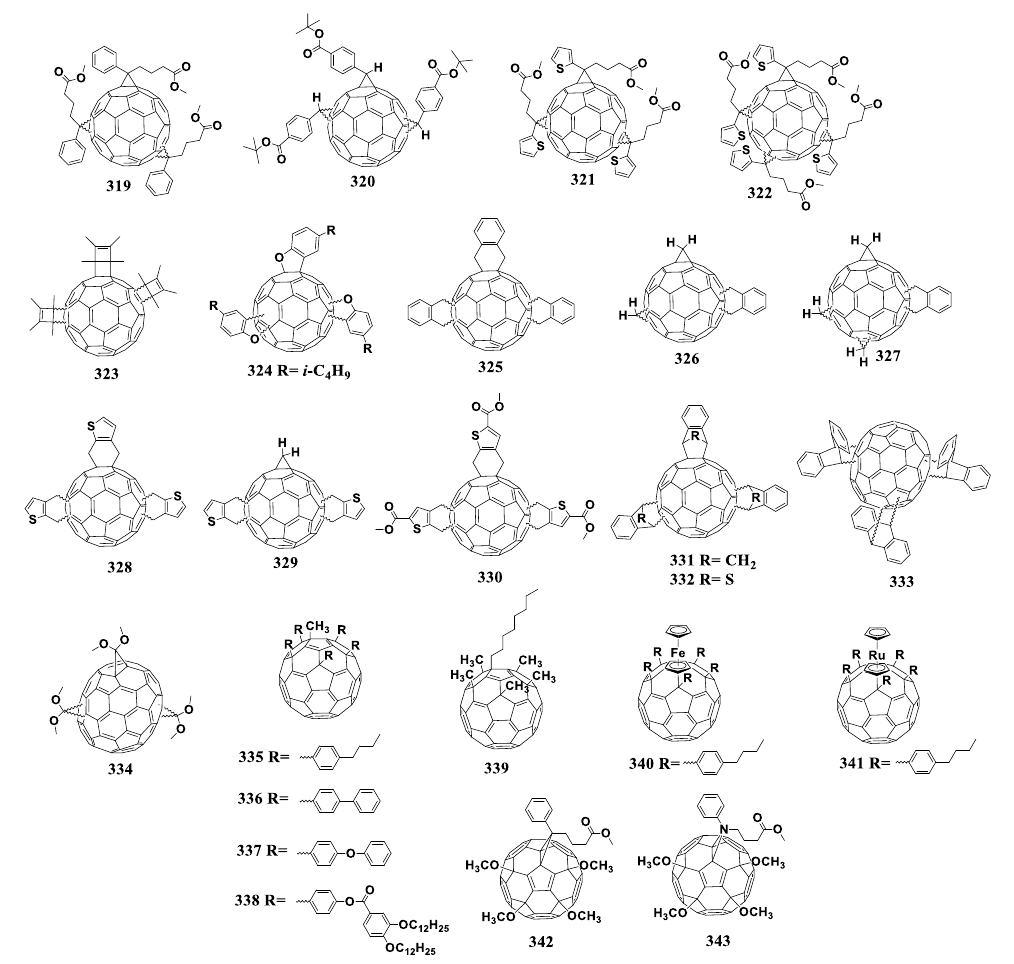
Figure 23. Molecular structures of the polyadducts with reduced electron